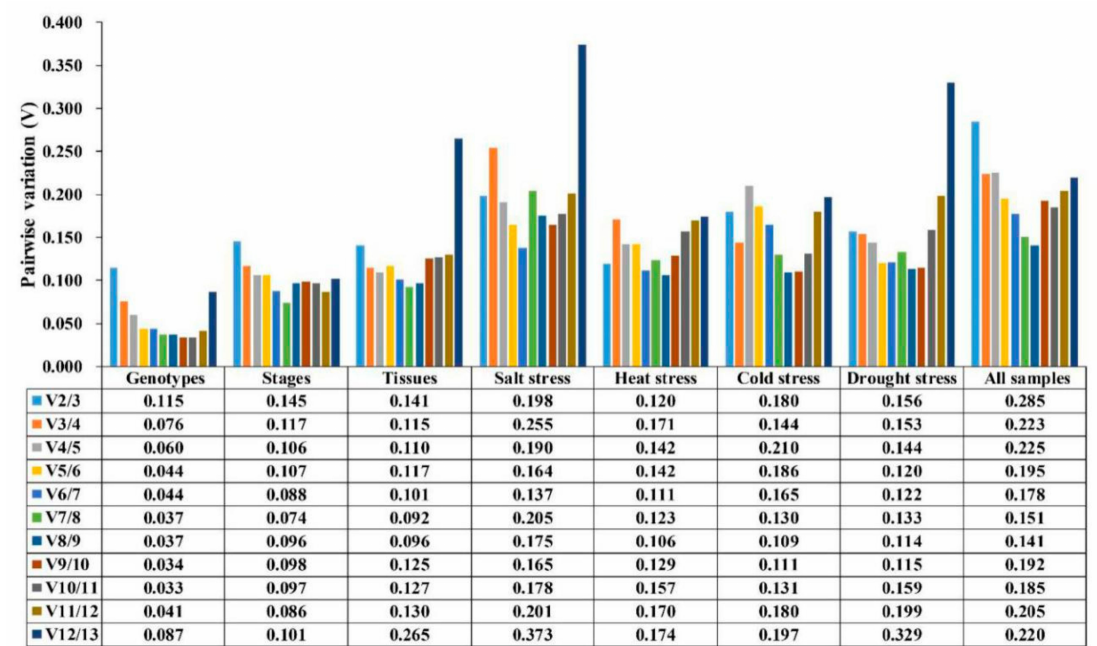
Figure 4. Pairwise variation (V) of 13 candidate reference genes under various experimental conditions calculated by